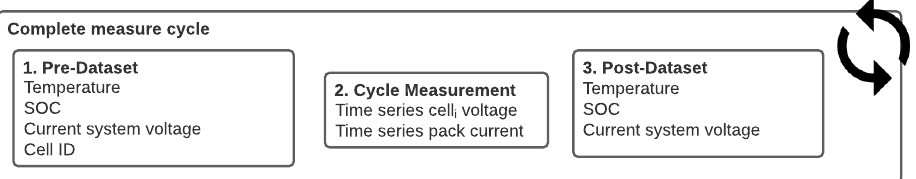
Figure 2. The measurement cycle for one cell is made up of three phases. One-shot measurements enclose the time series of one specific cell voltage and current